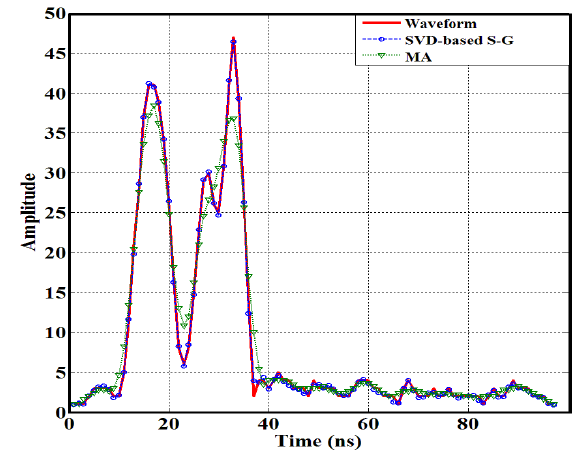
Figure 6. Smoothing a waveform via the SVD-based S-G and MA methods